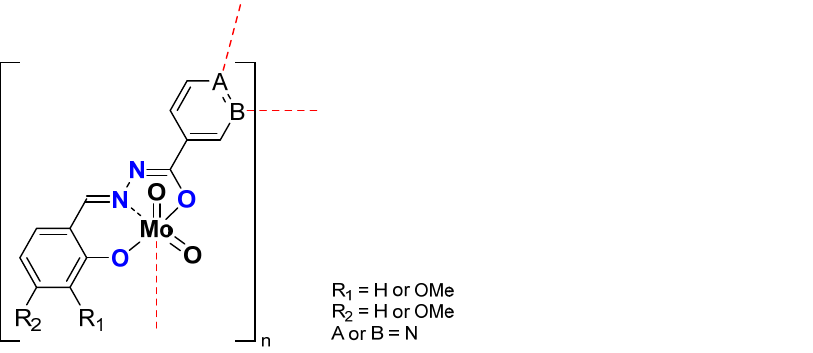
Figure 8. Schematic representation of neutral polymeric Mo species studied containing the nicotinoyl hydrazonato ligand. Table 5. Results of CO epoxidation and selectivity towards COE under organic solvent free conditions with MoO 2 L complexes from Figure 8.